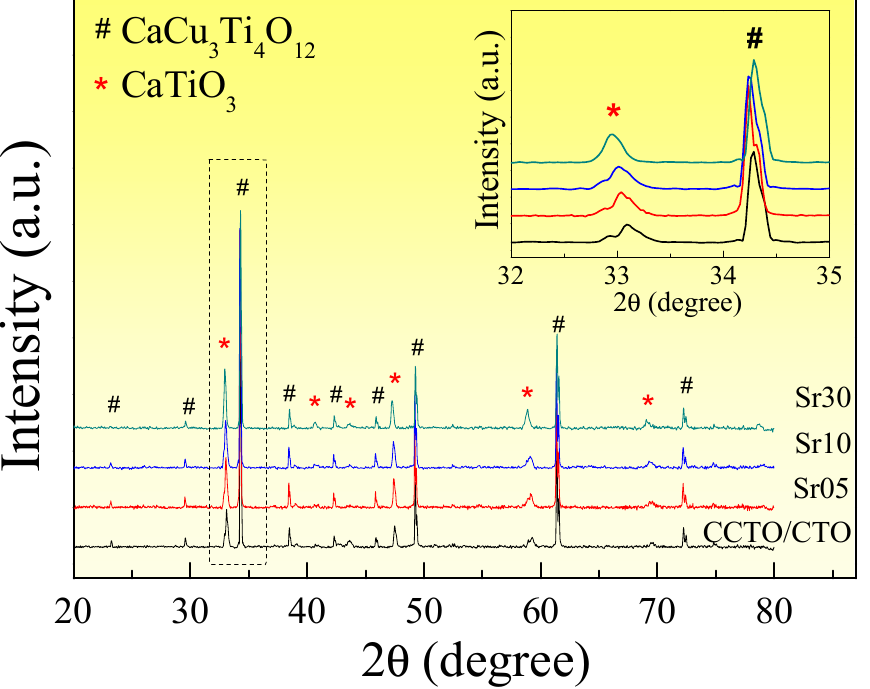
Figure 1. X-ray diffraction (XRD) patterns of all composite samples; inset shows shifting XRD peak ∼ 33.0° for the CaTiO 3 (CTO) phase.